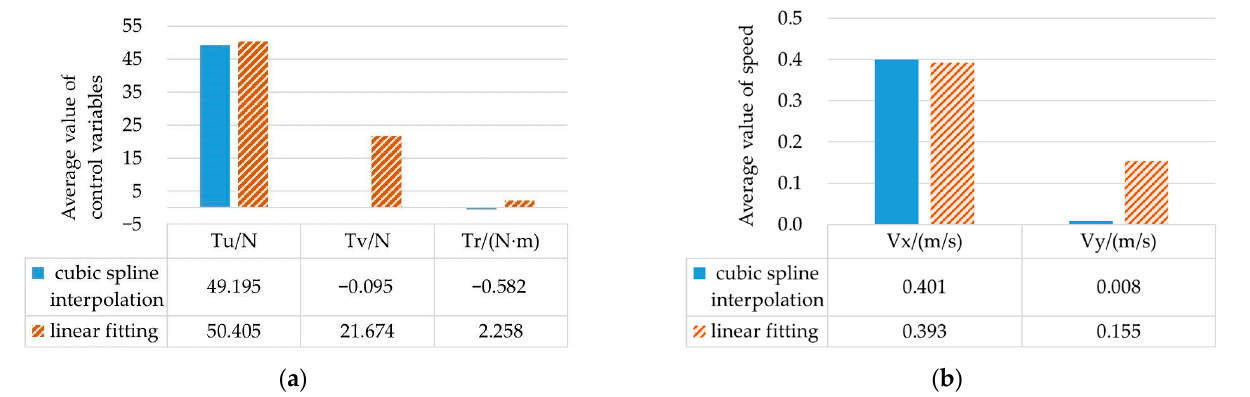
Figure 3. Average value of control variables and state variables in scenario 1 and scenario 2: ( a ) Average value of thrust and torque; ( b ) Average value of speed in x and y directions.